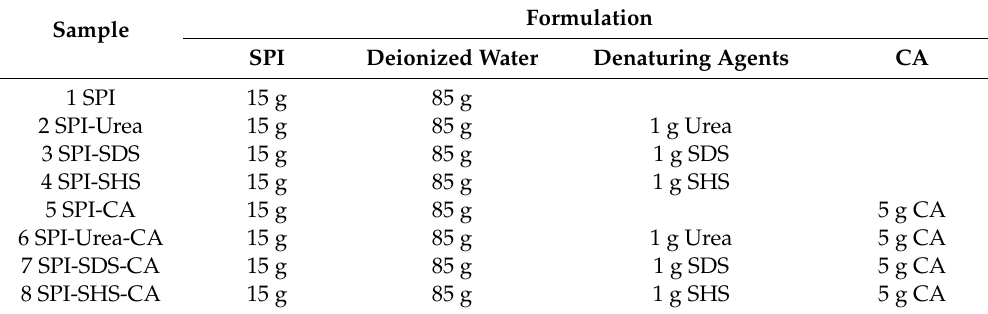
Table 2. Formulations used for adhesive samples.